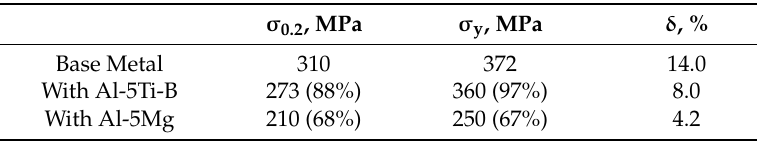
Table 2. Mechanical properties of the welded joint of AA7020.